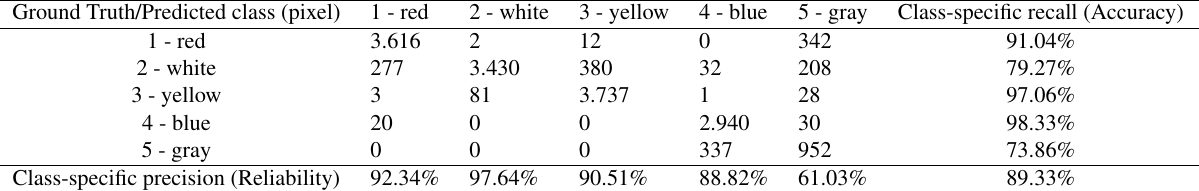
Table 2. Per pixel classification confusion matrix based on the orto rectified image of 2012 acquisition. Ground Truth/Predicted class (pixel)